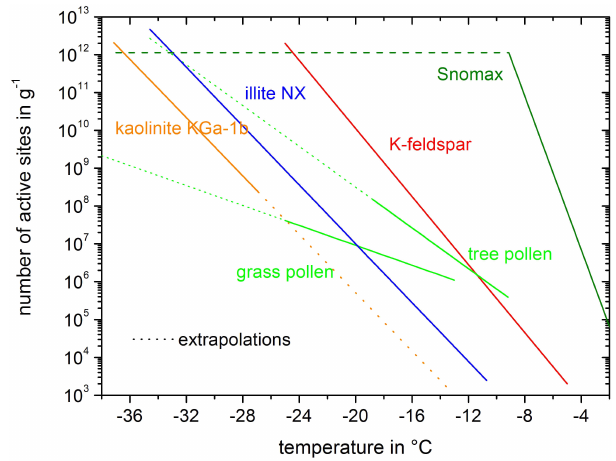
Figure 1. Numbers of active sites per unit mass as a function of temperature calculated by Eq. (2) with constants given in Table 1 for various particle types in the immersion mode. Based on laboratory data of immersion freezing experiments (Diehl et al., 2002; v. Blohn et al., 2005, pollen; Murray et al., 2011, kaolinite KGa-1b; Atkinson et al., 2013, K-feldspar; Hiranuma et al., 2015, illite NX; Wex et al., 2015, Snomax ® .